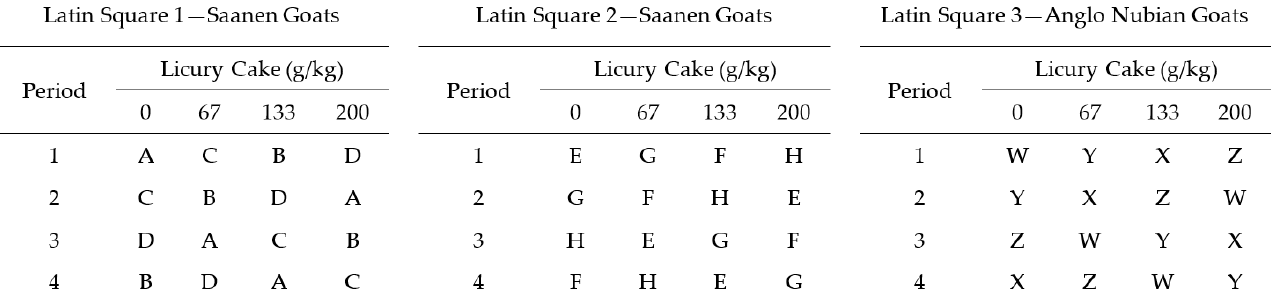
Figure 1. Experimental design considering three parallel Latin Squares of four periods and four treatments (animals: A, B, C, D, E, F, G, H, W, X, Y, and Z).